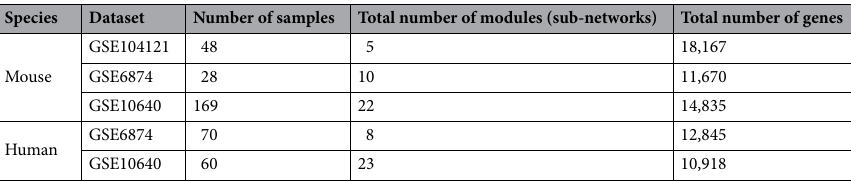
Table 1. Details of constructed gene coexpression networks under radiation treatments.